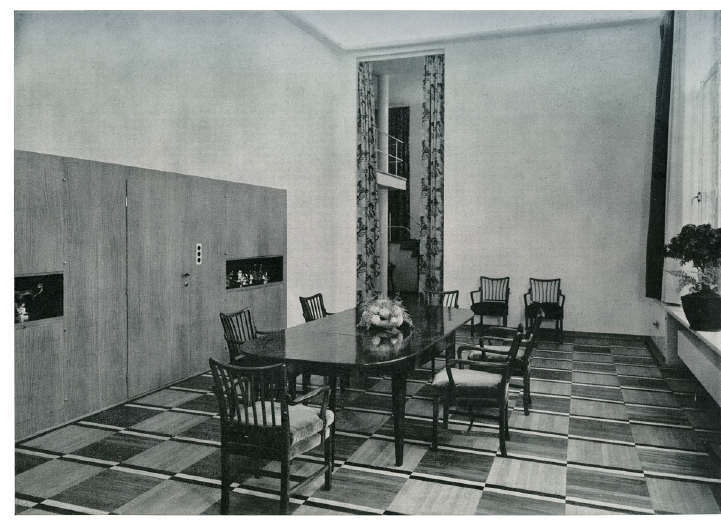
Fig. 5 Villa Beer, Vienna-Hietzing (1930), dining room, view to the north side; the wall show some irregularities, perhaps due to the facture (Source: Julius Scherb, Vienna